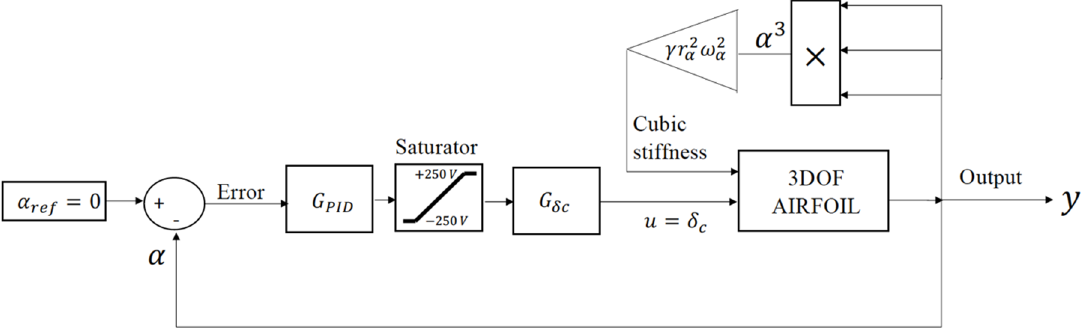
Figure 5. Closed-loop system.